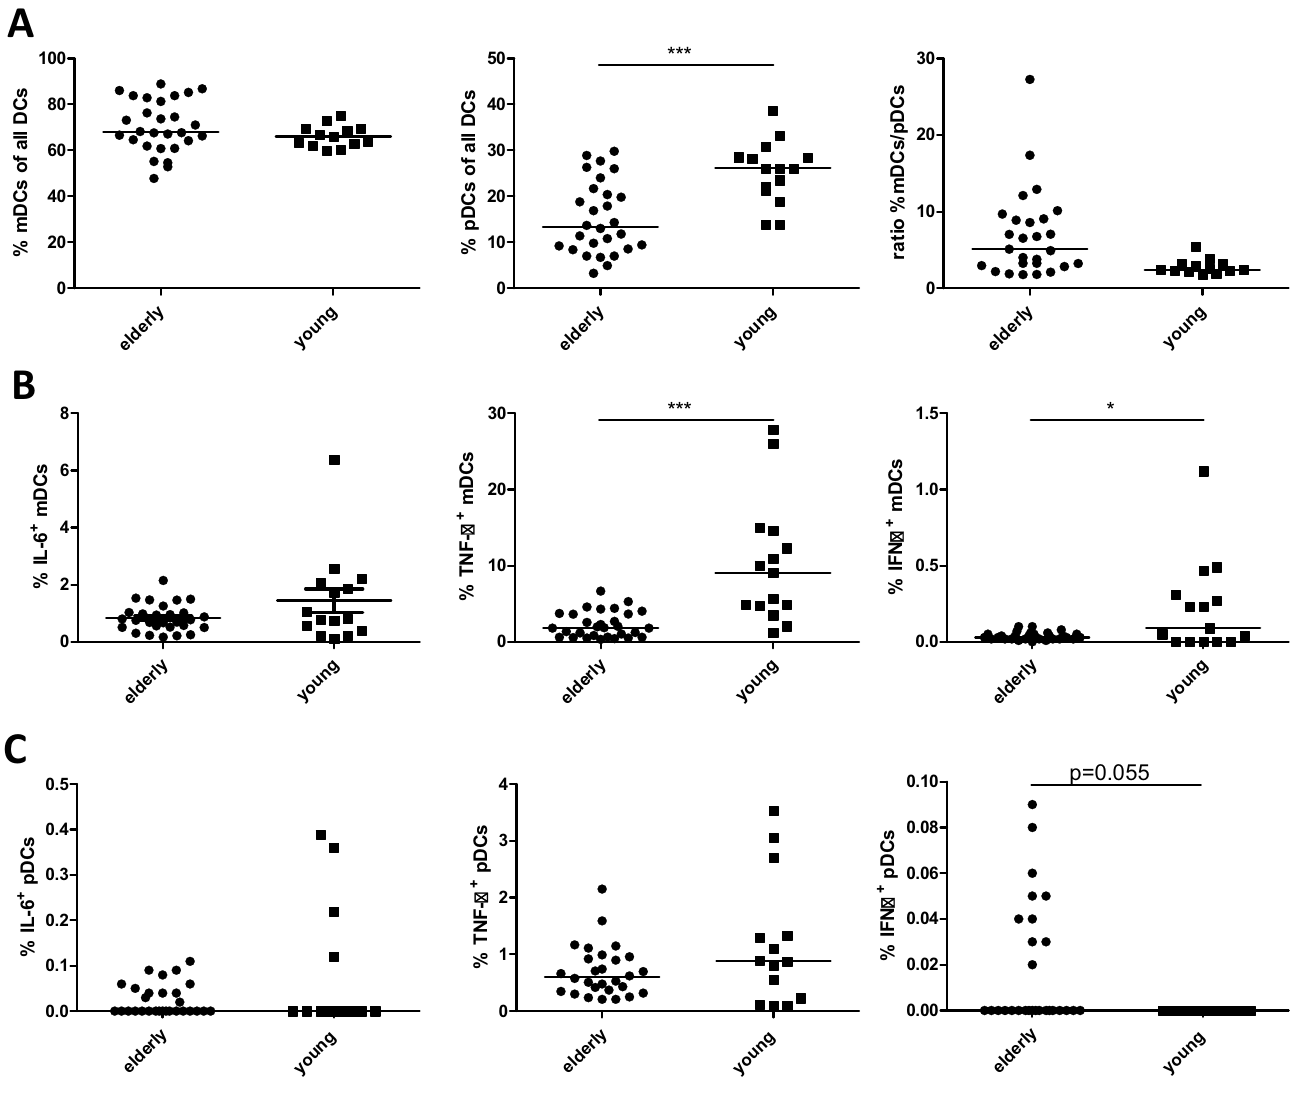
Fig 2. Percentage of pDCs and mDCs and ratio %mDC/%pDCs in elderly and young adults (A) and percentage of mDCs (B) and pDCs (C) positive for intracellular cytokine production of IL-6, TNF- α and IFN- α in steady state (RPMI). Data shown as dotplot with median, outliers with > 2SD based on transformed data were removed. Elderly n = 30; young n = 15 donors. Statistics were done with logit transformed data using MANOVA with a pairwise comparison and a bonferroni correction. � p < 0.05; �� p < 0.01; ��� p <